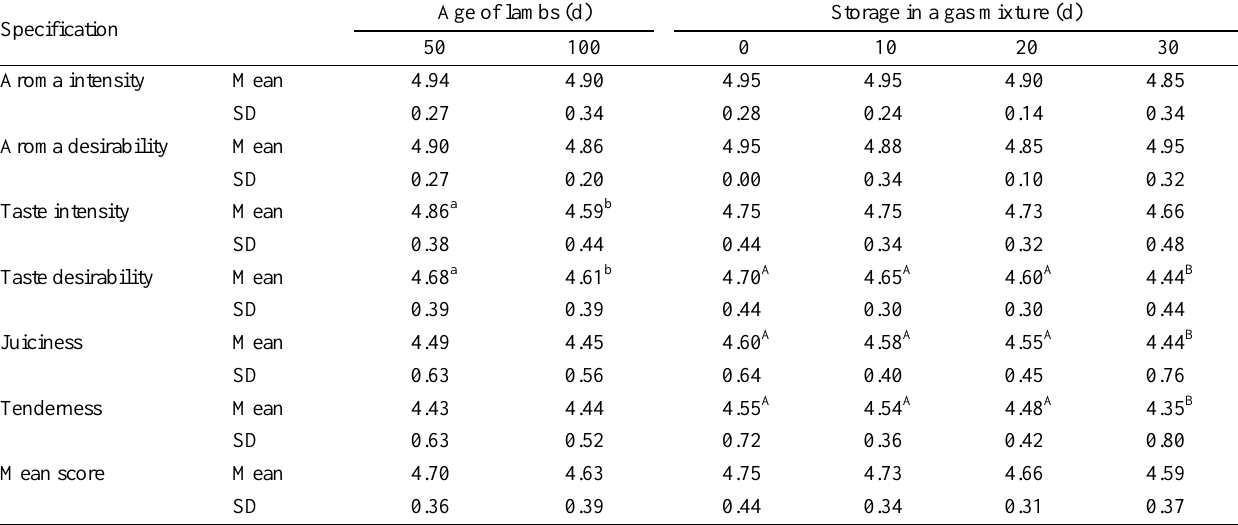
Table 3. Sensory evaluation of meat (points) Specification